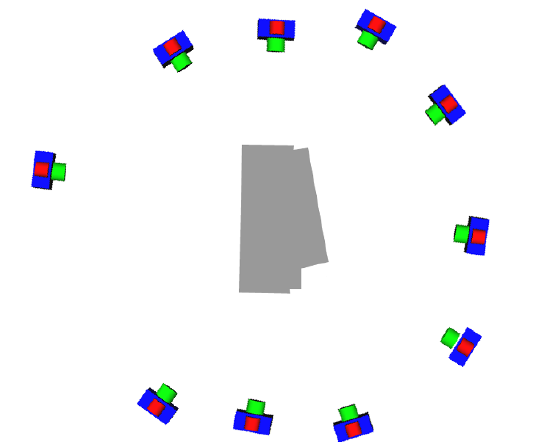
Figure 5. Canon EOS 5D Mk II network of images for 3D building modelling